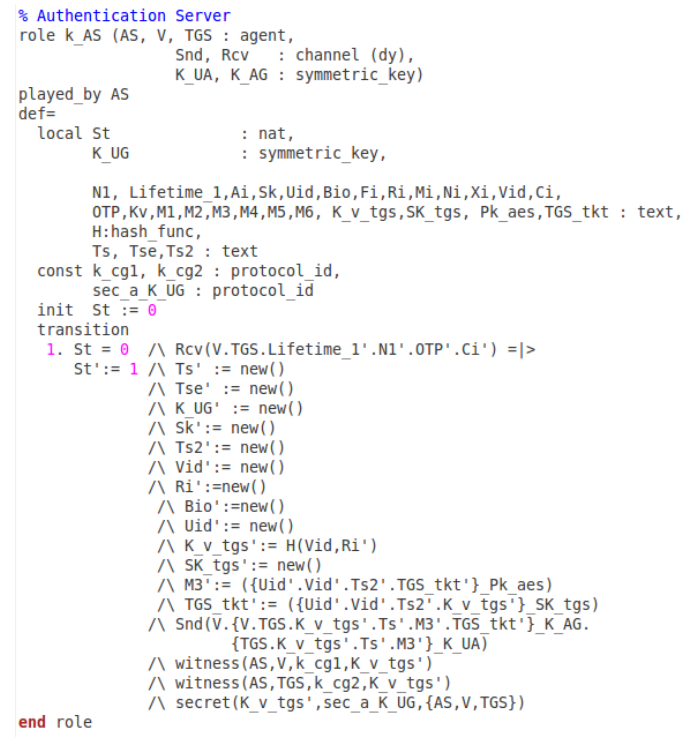
Figure 12. The AS’s role in